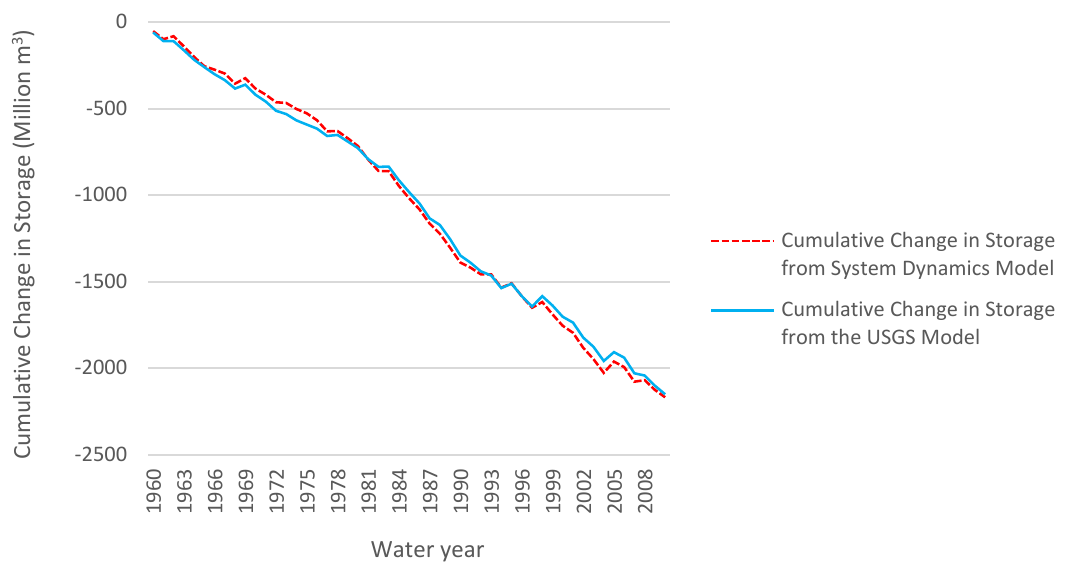
Figure 4. Comparison of cumulative change in storage for the Cuyama models.